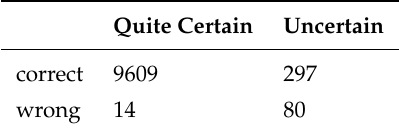
Table 5. Summary of network performance (network without dropout).